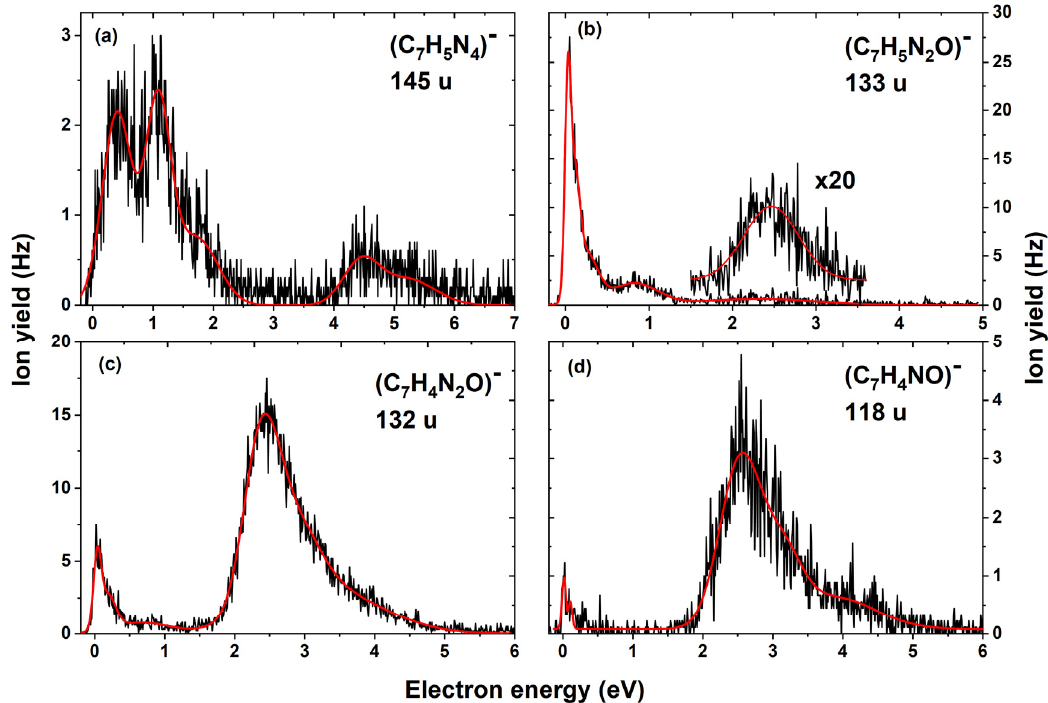
Figure 3. Anion efficiency curves for the formation of the anion with masses ( a ) 145 u, ( b ) 133 u, ( c ) 132 u and ( d ) 118 u upon electron attachment to tirapazamine. The solid red line is a cumulative sum of individual gaussian functions rendering the observed features.